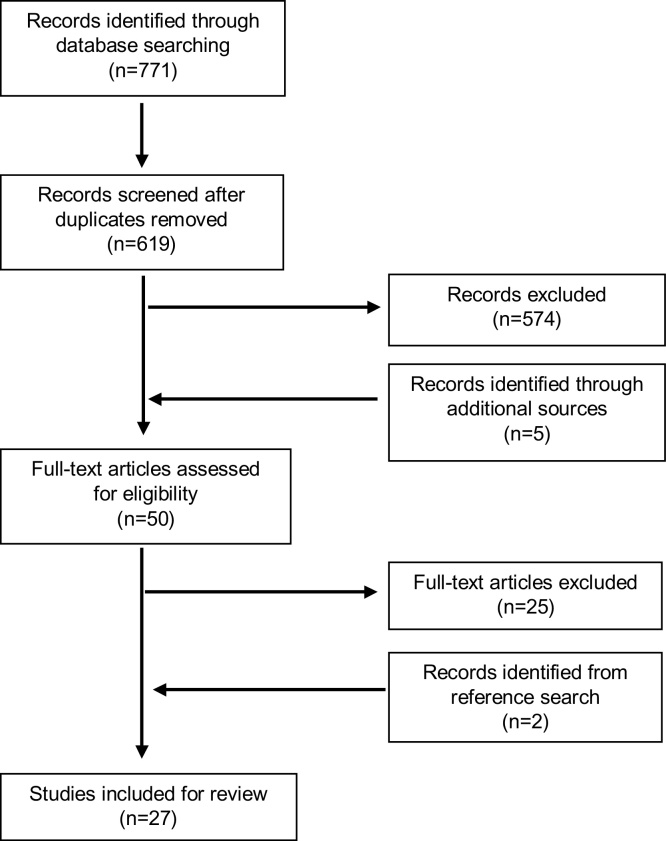
Prisma flow diagram.